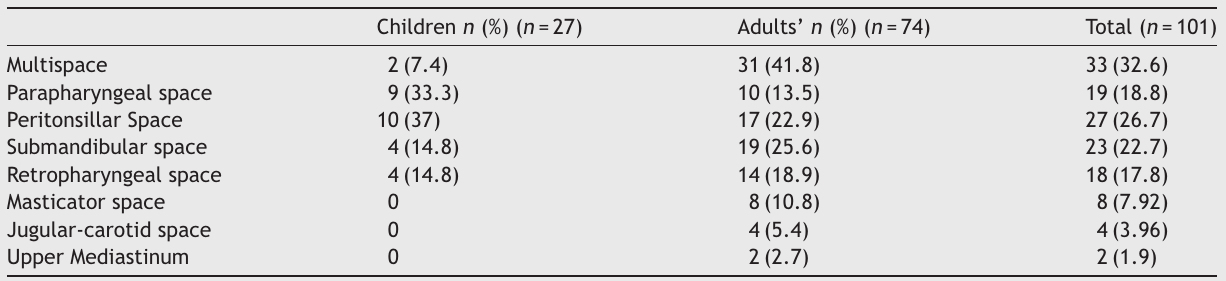
Distribution of the sites of deep neck